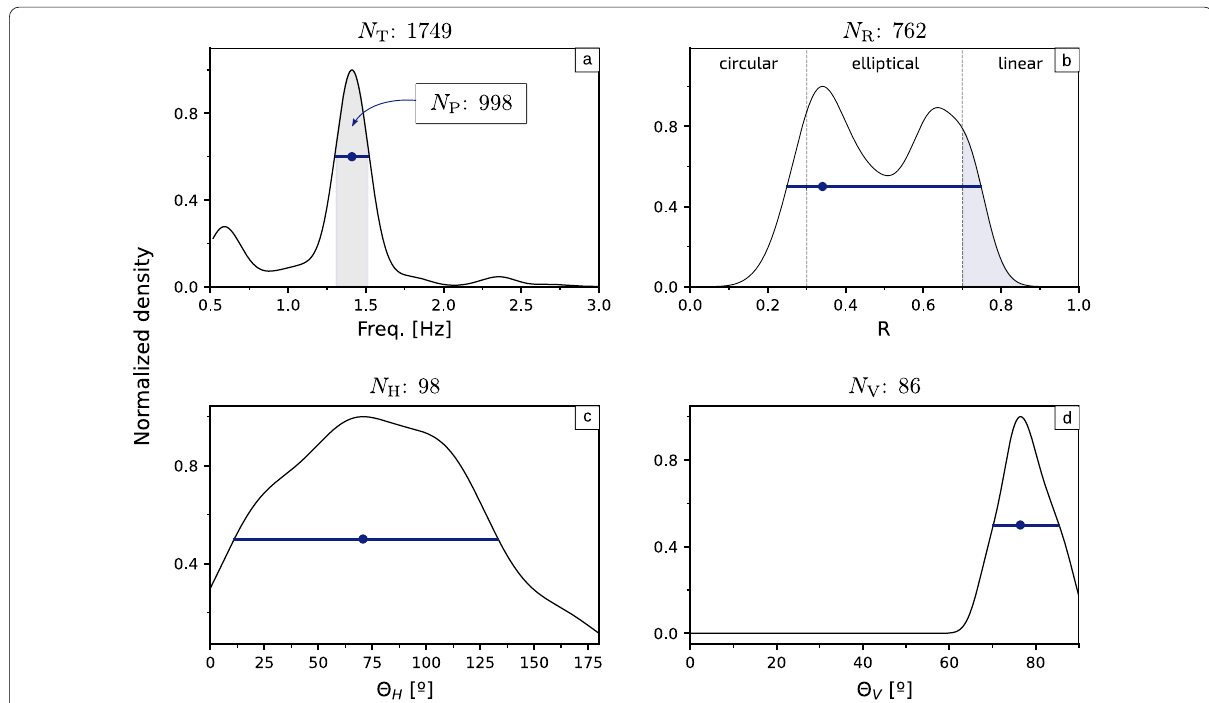
Fig. 3 Statistical analysis for the NB episode of Fig. 2. a The normalized PDF of the samples and weighted by their spectral energy. The peak centered at 1.4 Hz, which is the only peak above 0.6, is the characteristic peak of the episode. The normalized PDF of averaged rectilinearities R ( b ), horizontal azimuth (cid:31) H ( c ), and vertical incidence (cid:31) V ( d ) in the range ± 0.1 Hz around the characteristic peak. R , (cid:31) H , and (cid:31) V characterize the polarization of the peak by extracting the mode and range of each distribution. The range is the width of the distribution at 0.5 (blue horizontal lines in b – d ). The upper part of each plot gives the sample size of each PDF